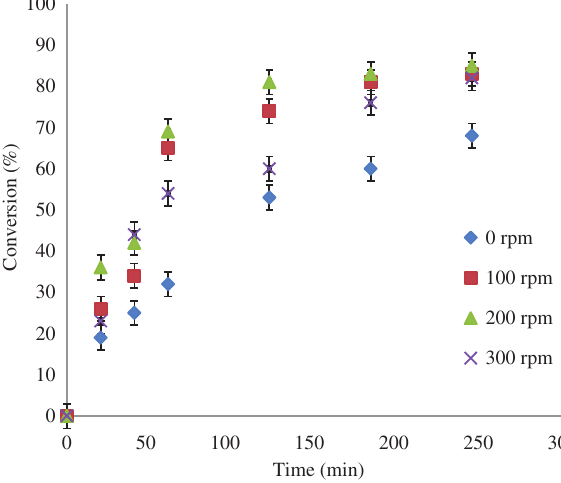
Figure 5: Effect of duty cycle on conversion at hexanol:triacetin ratio 1:1, hexane-3 ml, enzyme loading 4% (w/v), temperature 50 ° C, agitation speed 100 rpm, power 60 W and frequency 25 kHz.